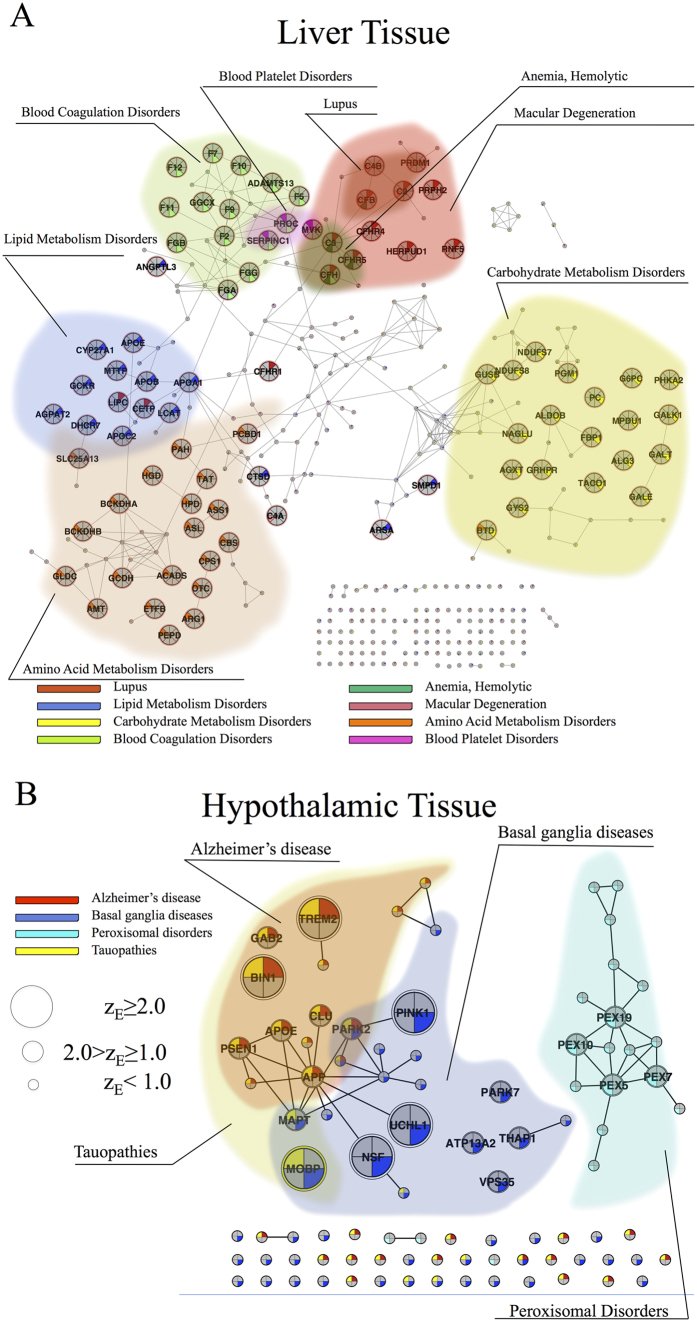
Diseases associated with liver and hypothalamus.(A) Diseases associated with the liver-specific interactome. (B) Diseases associated with the hypothalamus-specific interactome. Node sizes depend on the expression significance of the corresponding genes. We use pie-chart coloring to reflect disease-gene associations. To improve the readability of diagrams, we grouped genes related to the same disease into modules and highlighted each module accordingly. We excluded disease genes associated with nutritional and metabolic diseases from both panels owing to the large number of associated genes.